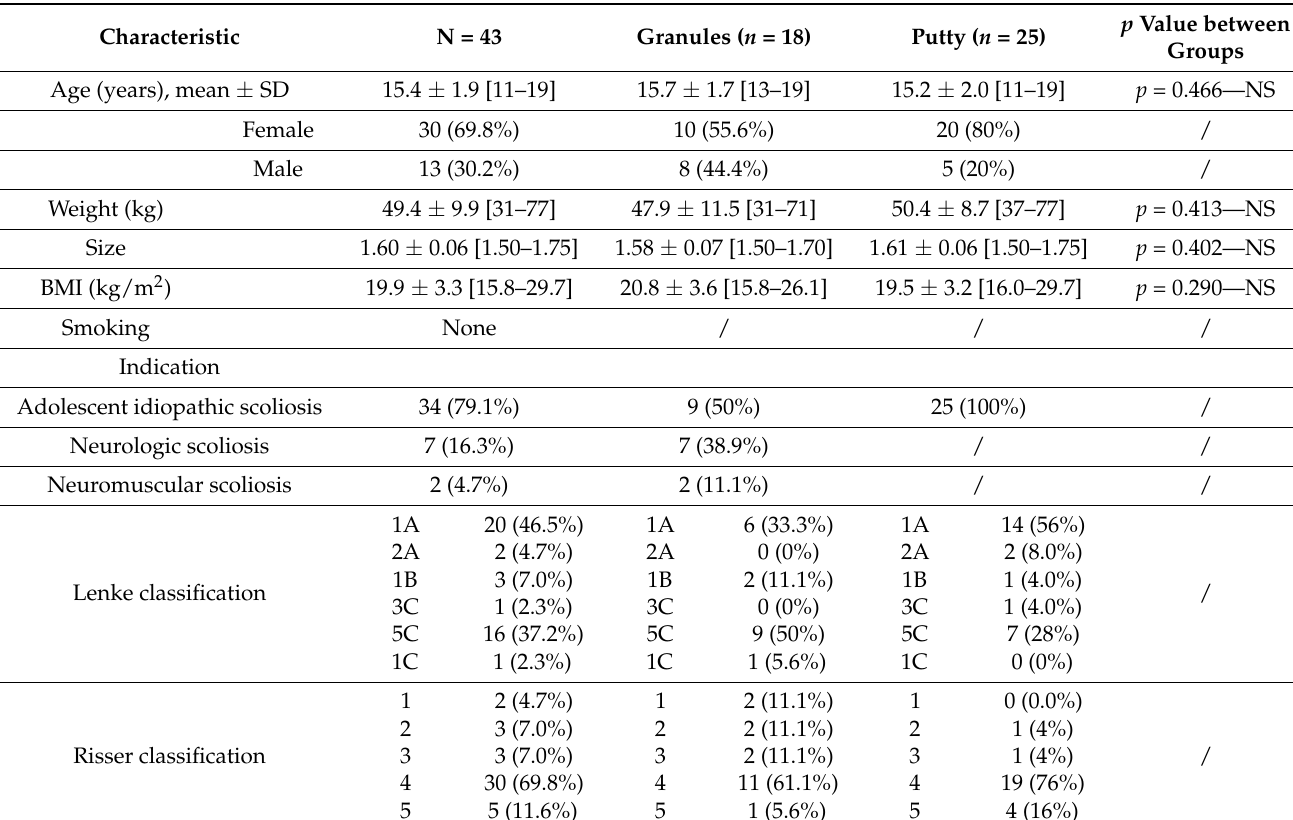
Table 1. Patient characteristics. Comparisons were computed between the granule and putty groups. There was no significant difference between the 2 groups.